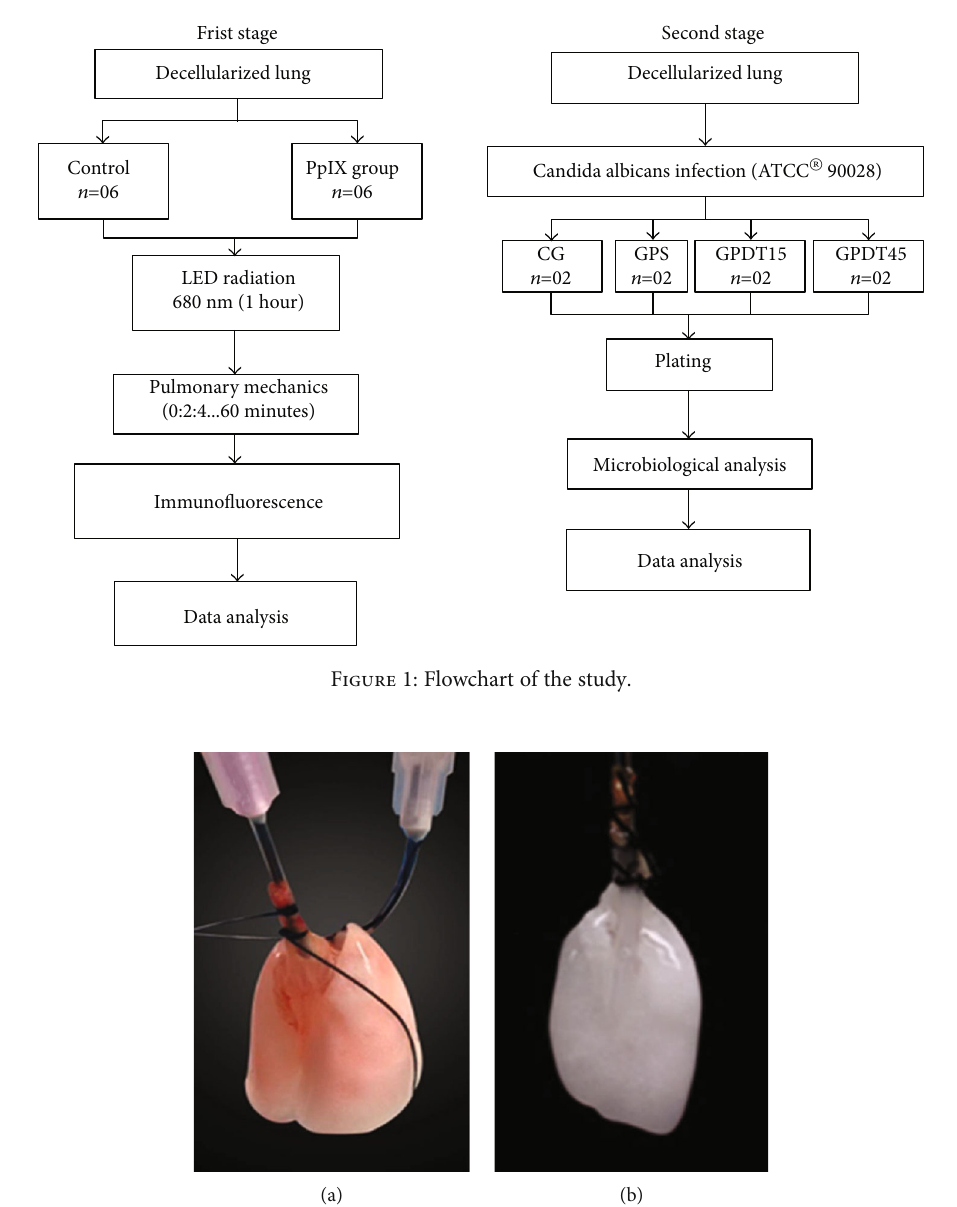
Figure 2: Decellularization process of the lungs. (a) Perfusion of the lungs with reagents through the trachea and the pulmonary artery. (b) Decellularized